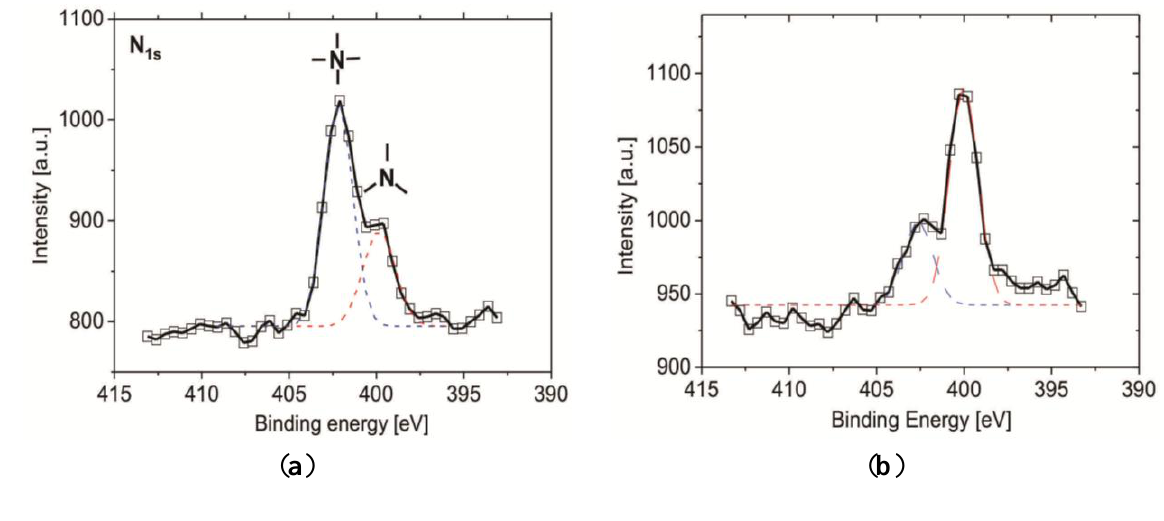
Figure 3. The N 1s spectra of the CB SAF. β-propiolactone reacted with tertiary amine (3°-N) groups on vapor- ( a ) and solution- ( b ) deposited silanized SAFs for 8 h to give the CB moieties. For uncharged 3°-N groups (-N(CH ) ), the appearance of the N 1s core-level signal 3 2 is at 399.1 eV; for 4°-N groups, the appearance of the N1s peak component is at 402.3